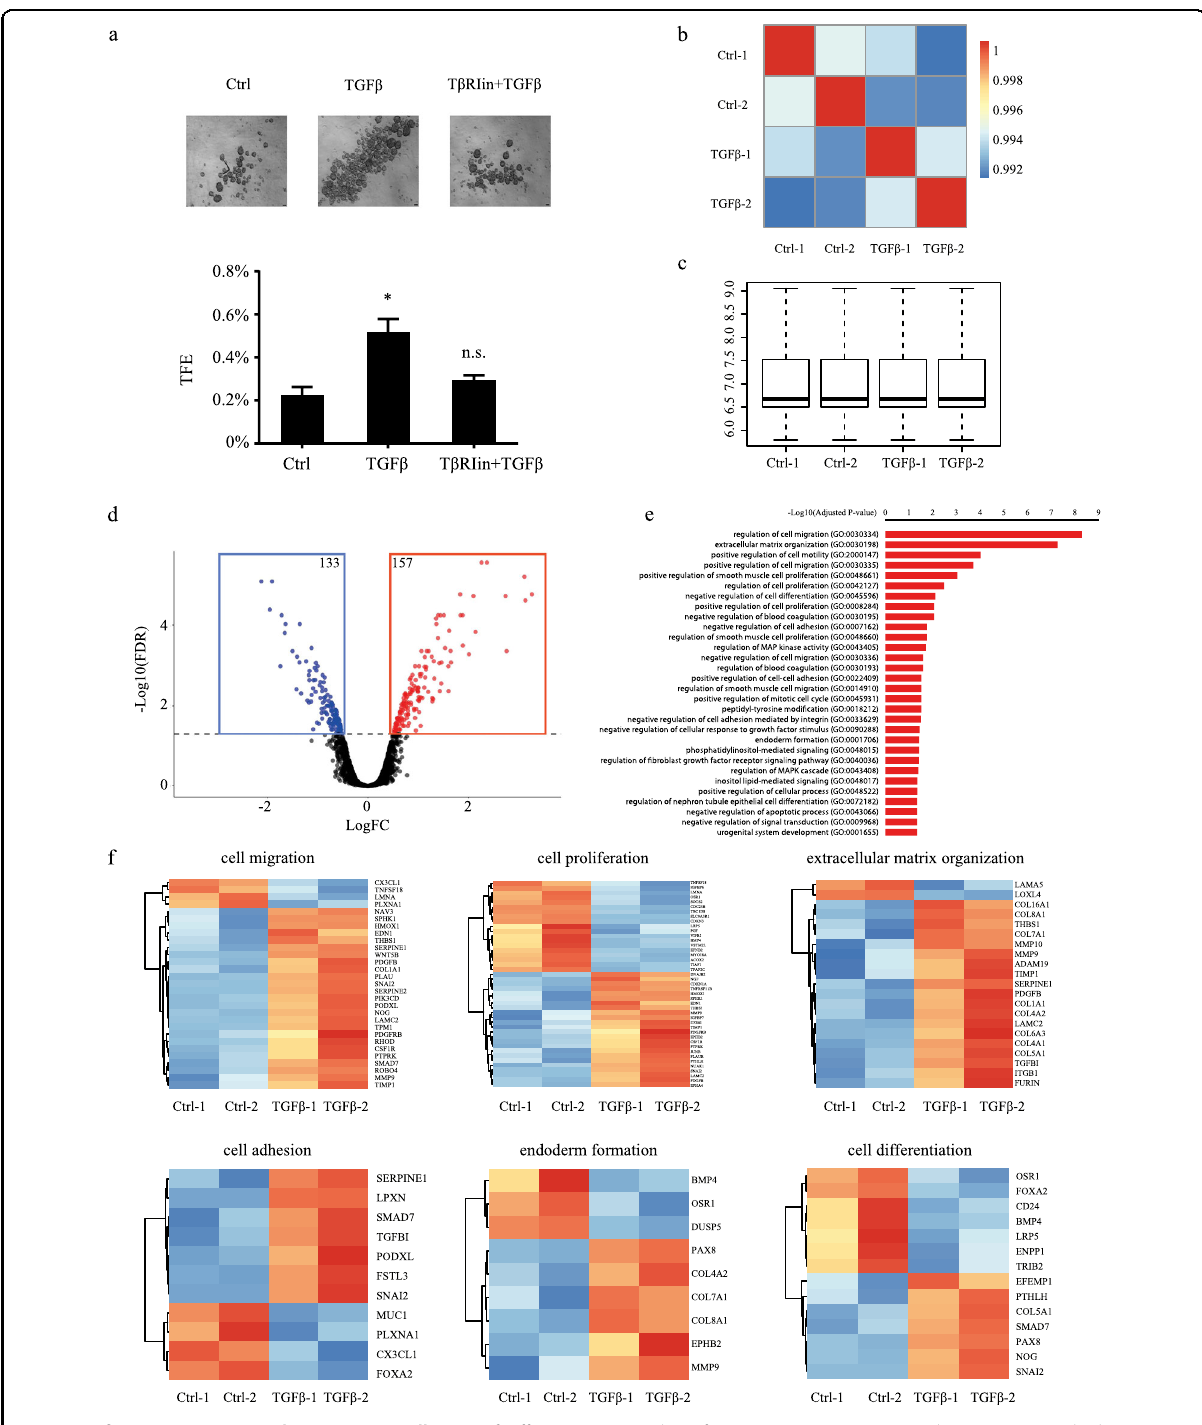
Fig. 1 TGF β transcriptomic analysis in TNBC cells. a TGF β effects on tumorsphere formation. Data are expressed as mean ± standard error. * P ≤ 0.05, n.s. not signi fi cant. b Pearson correlations and ( c ) normalized counts across all bioreplicates. d Volcano plot of differential expressed genes (red and blue indicate up- and downregulated genes, respectively (FDR < 0.05). e Gene ontology enrichment analysis of 290 candidate genes (FDR < 0.05) using EnrichR. f Heatmaps of the TGF β -regulated biological